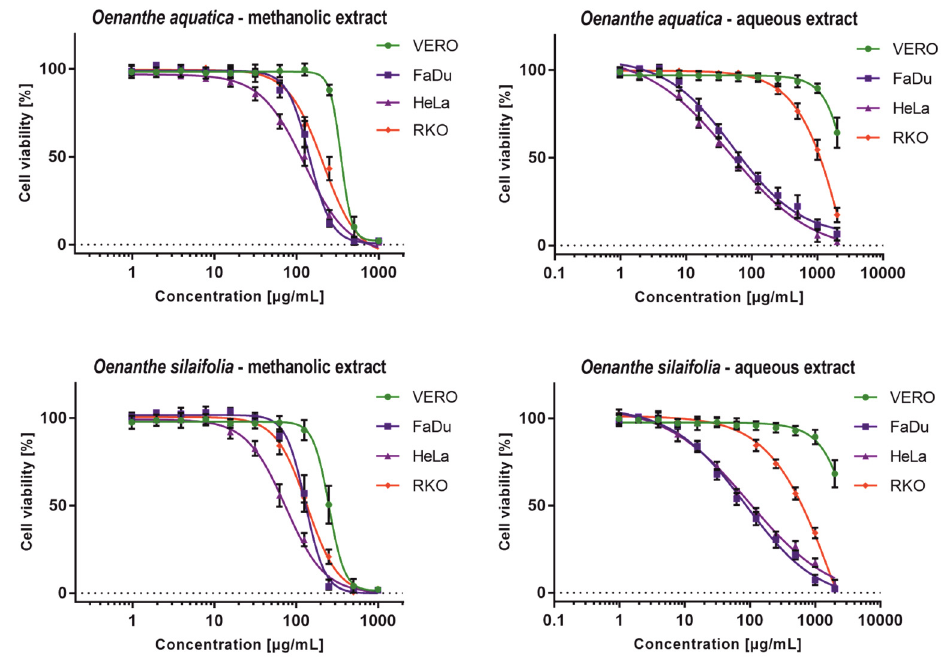
Figure 1. Dose-response influence of O. aquatica and O. silaifolia extracts on cell lines. The statistical significance of anticancer activity was analyzed using GraphPad Prism software (two-way ANOVA followed by Dunnett’s multiple comparisons test, analyzed with 95% confidence interval). We have compared the CC 50 values calculated for cancer cell lines with the ones observed for the VERO cells. In case of both methanolic extracts, the differences of CC 50 values between cancer and normal cells were statistically highly significant ( p < 0.001). However, because our study design did not allow for accurate measurement of aqueous extracts CC 50 on VERO cells, we could not subject them